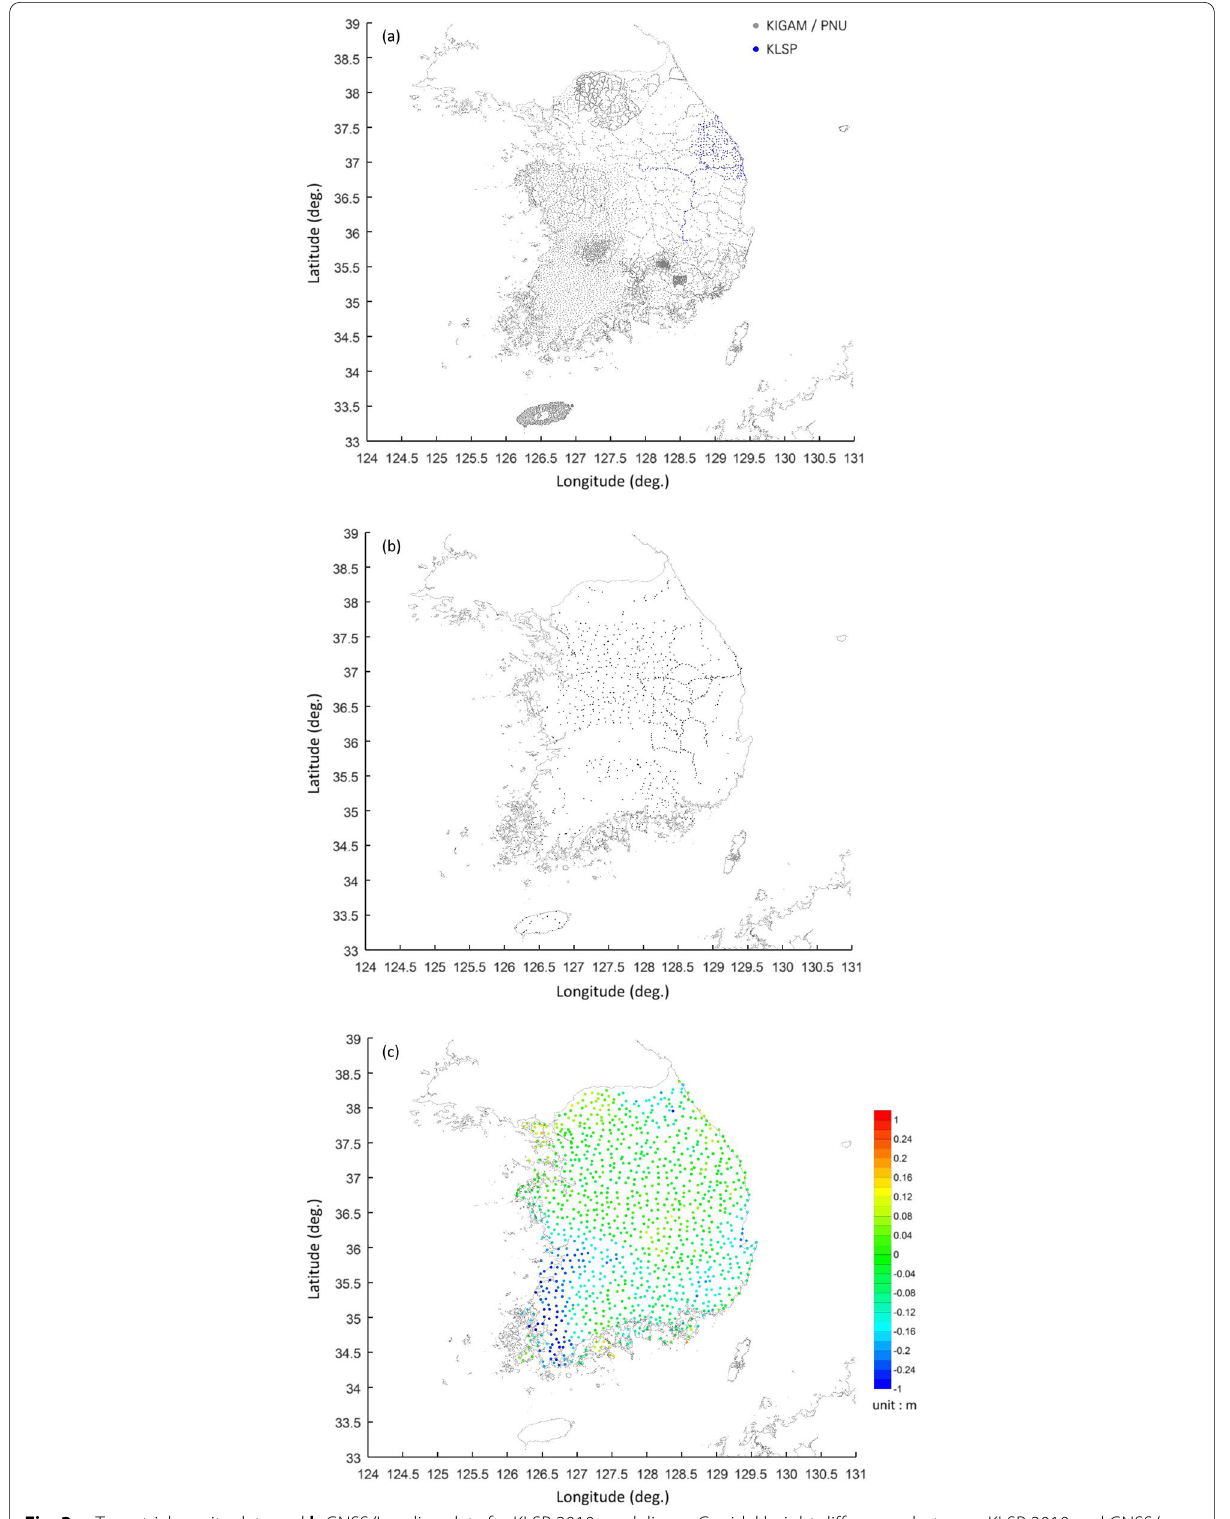
Fig. 3 a Terrestrial gravity data and b GNSS/Leveling data for KLSP 2010 modeling. c Geoidal height differences between KLSP 2010 and GNSS/ Leveling data obtained by the NGII [re-plotted referring to the fundamental data of Kwon et al.